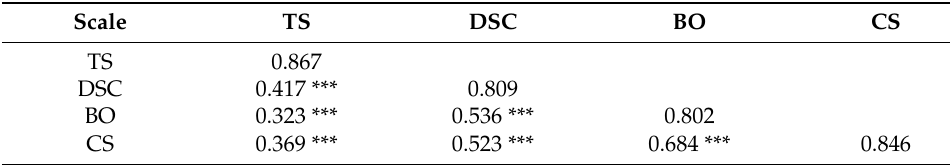
Table 3. Discriminant validity of the research